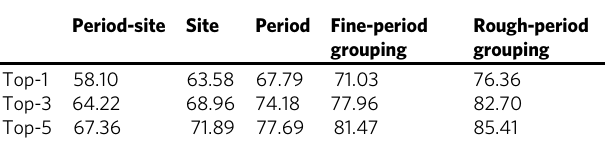
Table 1 Prediction accuracy [%] for period-site, site, period, fi ne-, and rough-period